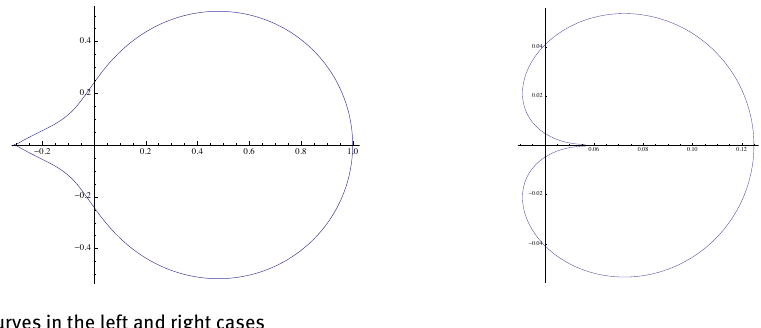
is greater at a point above the e 1 -axis with tangent vector in the third quadrant than at the point of the same height with tangent vector in the second quadrant. As a result, the curve has a vertical tangent before it meets the e 1 -axis again and then curves in to meet the axis at an angle (Fig. 1, right). In the left case, the opposite inequality regarding curvatures holds, and, as a result, the curve never returns to vertical before reaching the axis (Fig. 1, left). The left case presents the new challenge of showing that there is only one point on the upper half of the curve where the tangent vector is horizontal (Prop. 7.22). Additionally, although the curve in the right case is similar to that in Chambers, the proof is different in that we do not have the hypothesis that an isoperimetric hypersurface is mean convex, which is what Chambers used to prove that curvature was positive on the final segment of the curve ([1, Prop. 4.1]). We achieve the same result by computations that depend on the fact that our curve ends right of the e 2 -axis (Lemma 6.15), which is a property that may not hold for the generating curve in